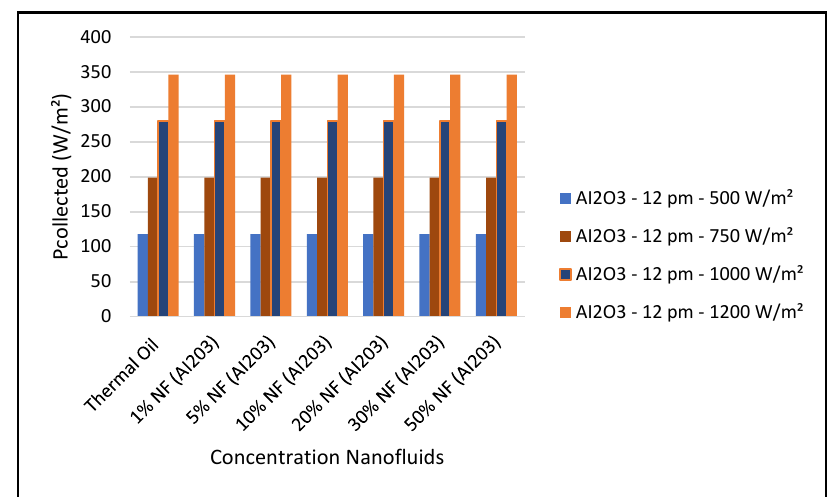
ff erent concentrations of Al 2 O 3 and solar radiations.